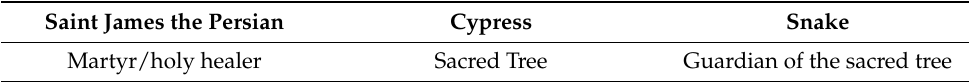
Table 3. Relationship of Iconic Elements at Ayios